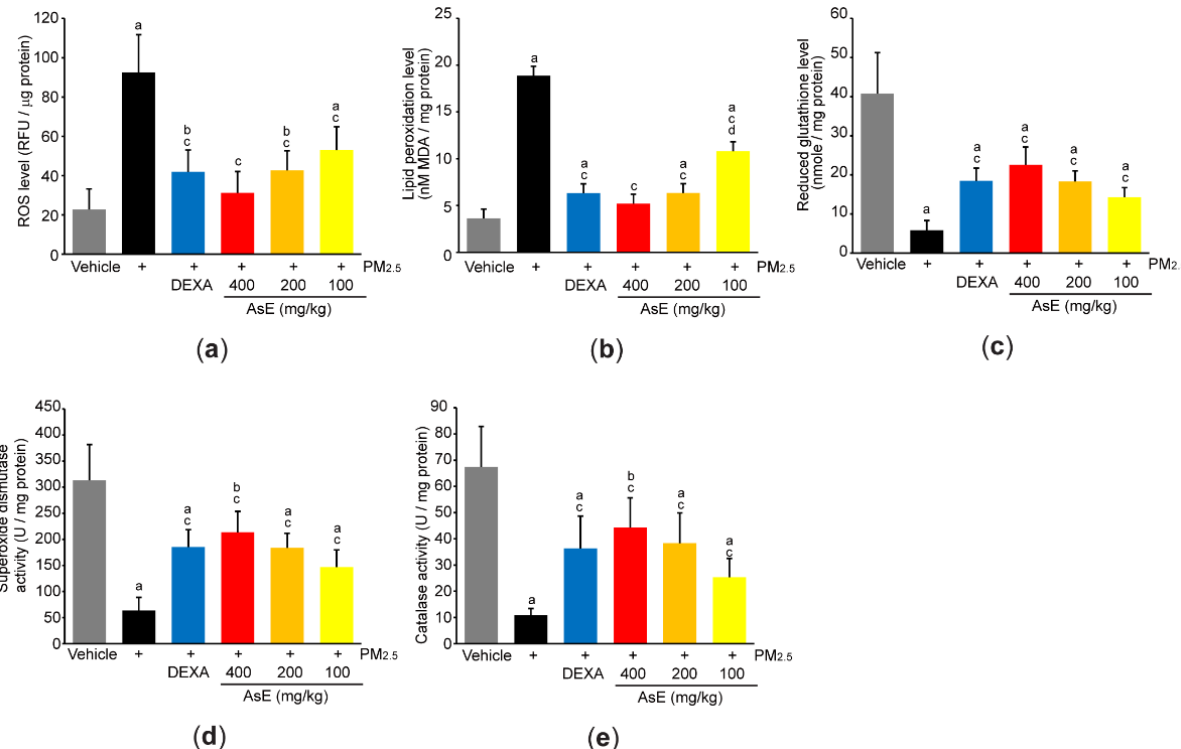
Figure 7. AsE suppresses oxidative stress in the lungs. ( a ) ROS production. Fluorescence intensity was measured after reacting the lung homogenate with 2′ , 7′ -dichlorofluorescein diacetate. ( b ) MDA concentration of the lung homogenate was monitored as an indicator of lipid peroxidation. ( c – e ) Antioxidant capacity. Reduced glutathione level ( c ) and superoxide dismutase ( d ) and catalase ( e ) activities were measured from the lung lysates. a p < 0.01, b p < 0.05 versus vehicle group; c p < 0.01 versus PM 2.5 group; d p < 0.01 versus PM 2.5 + DEXA group; MDA, malondialdehyde; RFU, relative fluorescence unit; U, unit.